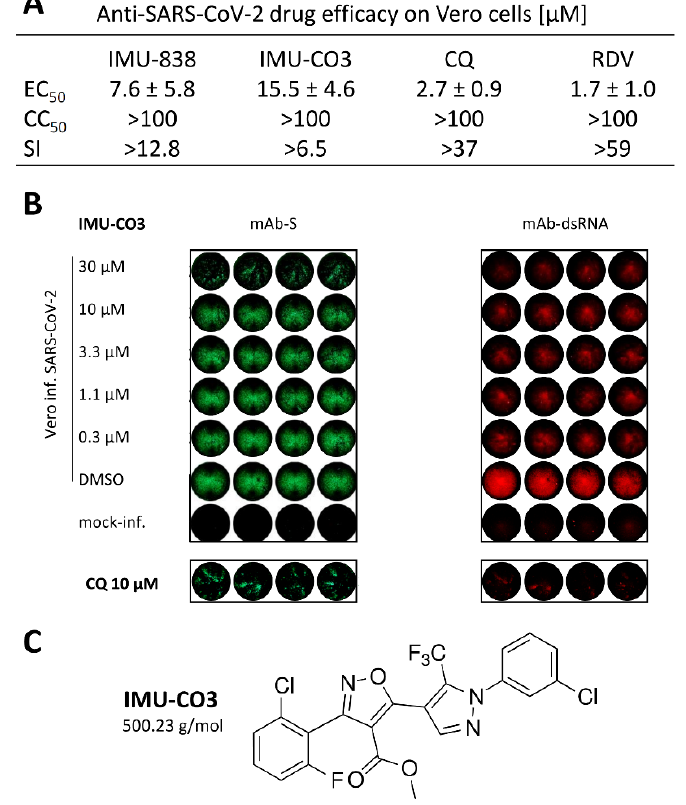
Figure 5. Determination of the anti-SARS-CoV-2 activity of DHODH inhibitor back-up compound, IMU-CO3. As based on the experimentation performed with IMU-838 shown in Figures 2–4, a similar in vitro characterization of anti-SARS-CoV-2 activity was performed with IMU-CO3. ( A ) RT-qPCR using infectious supernatants of SARS-CoV-2-infected Vero cells was used to assess the antiviral efficacy in quantitative terms. EC 50 values ± SD are given and set in relation to CC 50 and SI values. Values for reference compounds chloroquine (CQ) and remdesivir (RDV) were determined using the same test system. ( B ) In-cell IF stainings using mAb-S and mAb-dsRNA were performed to demonstrate the intracellular antiviral efficacy on the levels of inhibition of viral spike protein production and genomic viral RNA, respectively. Note the double-staining of drug-treated, infected Vero cell wells by the use of isotype-specific secondary fluorescence-labeled antibodies. Control staining is shown for the reference compound CQ. (C ) Structure of the DHODH inhibitor IMU-CO3.